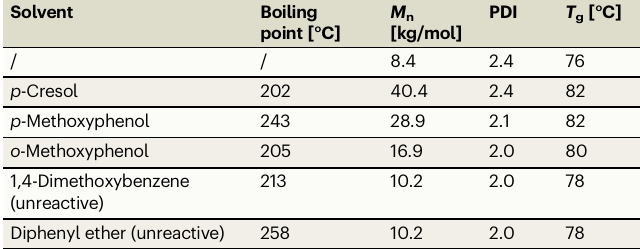
Table 3 | In fl uence of catalyst on molecular weight and T g of PIsSu Catalyst